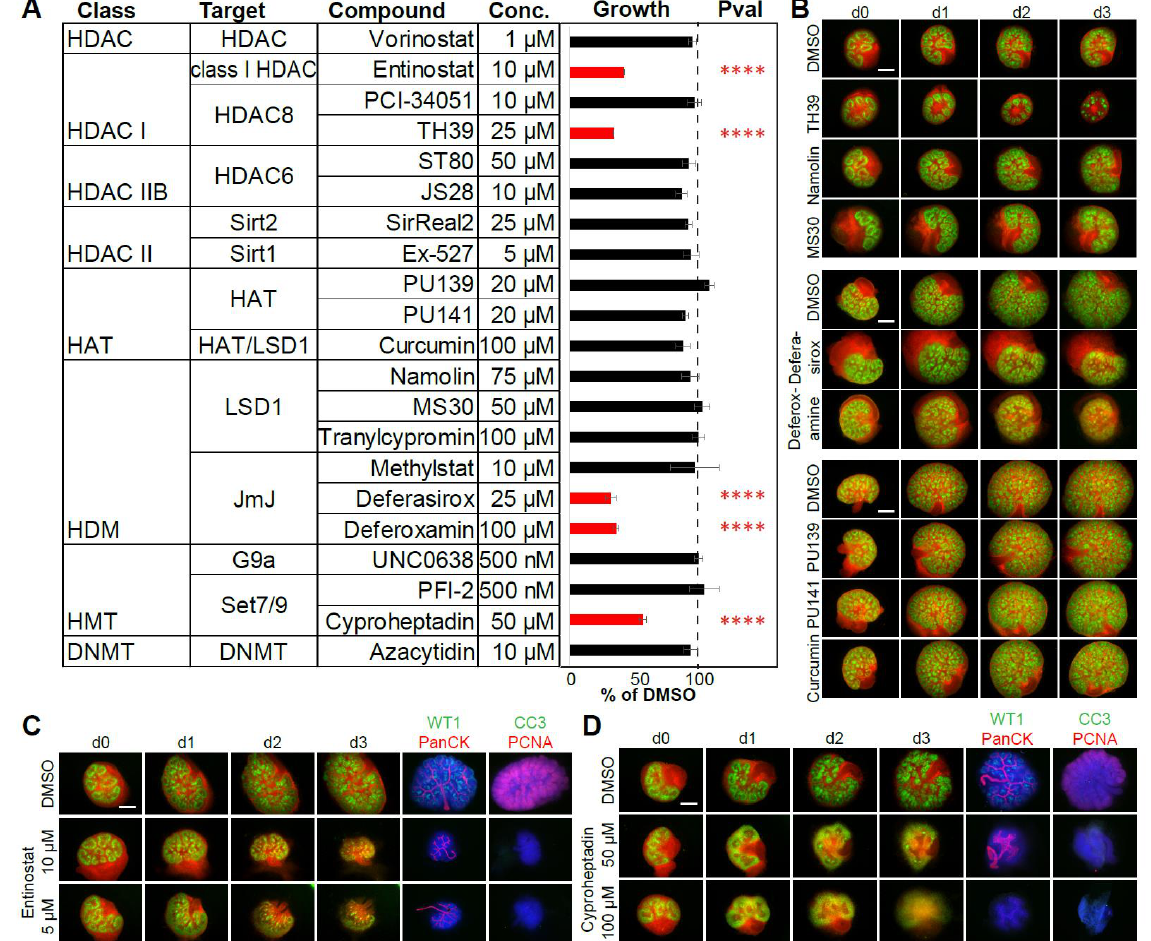
Figure 4. Ex vivo small compound screen identifies modulators of renal development. ( A ) List of small compounds, their epigenetic targets and concentration used shows renal growth reduction with entinostat, TH39, deferasirox, deferoxamine and cyproheptadine in ≥ 3 independent experiments after 3 days in culture. Control cultures were treated with DMSO. ****, p -value < 0.0001. ( B ) Examples of two sets of embryonic kidney cultures with pictures taken from day 0 until day 3 showing growth reduction and morphological differences in kidneys treated with TH39, deferasirox and deferoxamine compared to littermate control kidneys. Scale bar: 500 µm. ( C ) Entinostat showed growth reduction at 5 and 10 µM concentration, no nephron differentiation and lack of proliferation after 3 days. ( D ) Cyproheptadine showed growth reduction at 100 and 50 µM concentrations, lack of differentiation, ureter dilation and lack of proliferation after 3 days in culture. Scale bar: 500 µm. PanCK, pan-cytokeratin. CC3, cleaved caspase-3. PCNA, proliferating cell nuclear antigen.